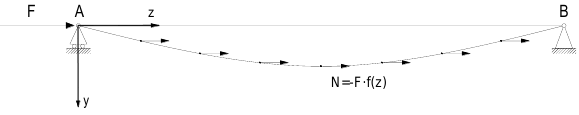
Figure 1: Geometric scheme of the